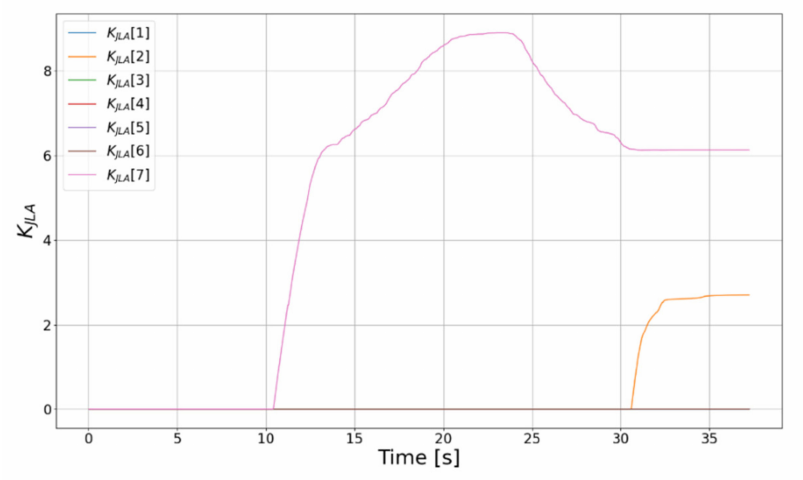
Figure 22. Evolution of the diagonal weighting values related to each robot joint for the adaptive JLA